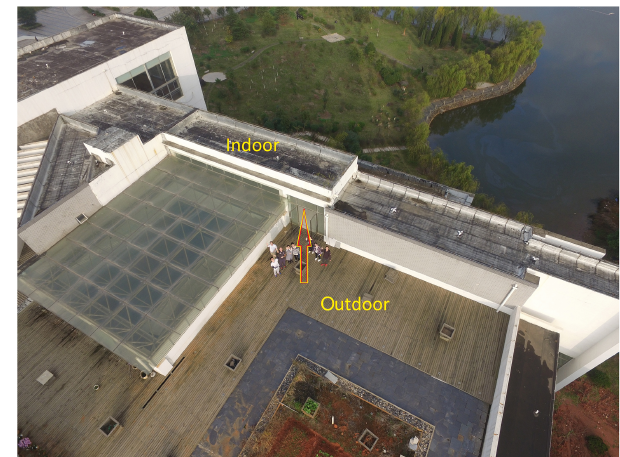
Figure 4. Experiment location (picture taken by the first author us- ing DJI Phantom 3 drone).